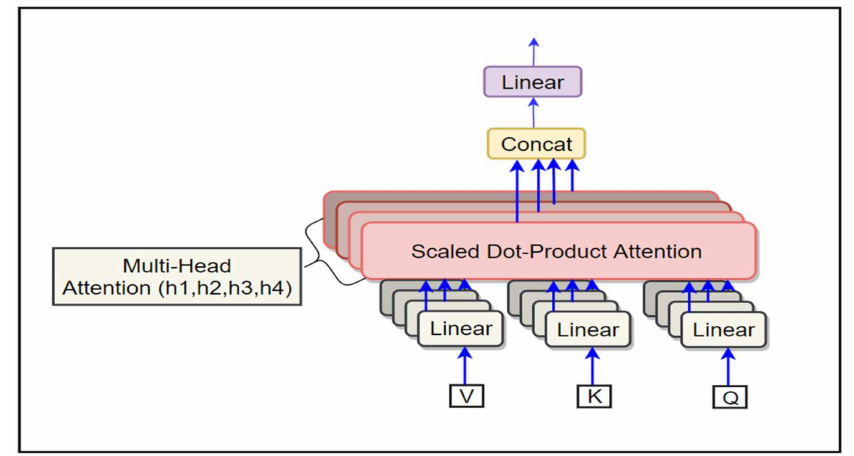
Figure 2. The Multi-Head Attention consist of several attention layers running in parallel. √ d k is performed to measure the output of the prod- The division of Q × K T by uct operation so maintaining the calculation Vaswani et al. [4]. The overall attention weight distribution is obtained by applying the so f tmax ( . ) operation to the attention score α ∈ R Z × J . For better performance, the transformer architecture uses MHA, which com- prises N h (number of head attentions) measured dot product attention operations.